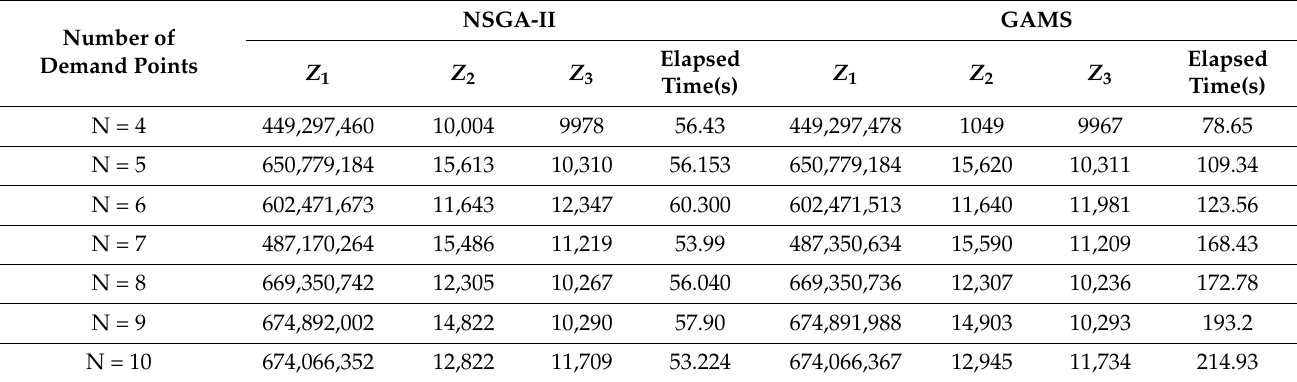
Table 8. Comparison of the answer of NSGA-II with the exact solution in small